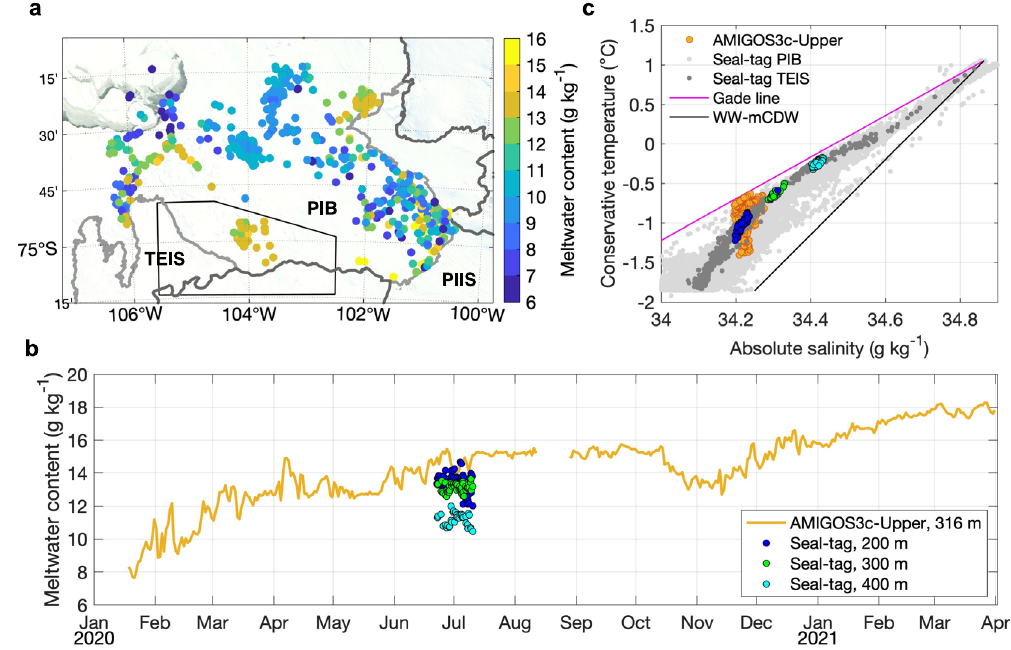
Fig. 6 | Meltwater content at Pine Island Bay (PIB) from seal-tag data. a Meltwater content at 200m depth derived from seal-tag data collected between MayandOctoberof2020.Theblackpolygonshowstheareausedtoselecttheseal- tagdatanearThwaitesEasternIceShelf (TEIS).TerraMODISopticalimageryfor10 September 2020 is shown. Grey contours show land (dark) and ice shelves (light). Pine Island Ice Shelf (PIIS) is depicted. b Time series of meltwater for AMIGOS3c- Upper (orange, same as in Fig. 1e) and for the seal-tag data at 200m (blue), 300m